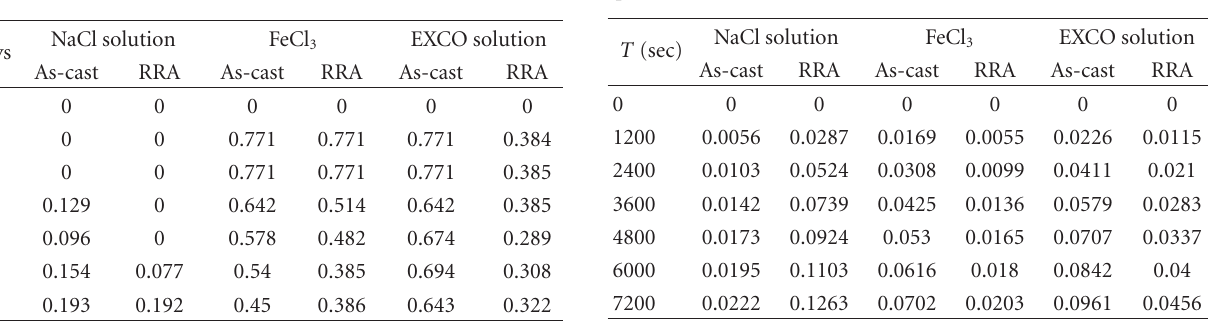
Table 12: Electrochemical corrosion rate for the 1.51% Mg specimen.